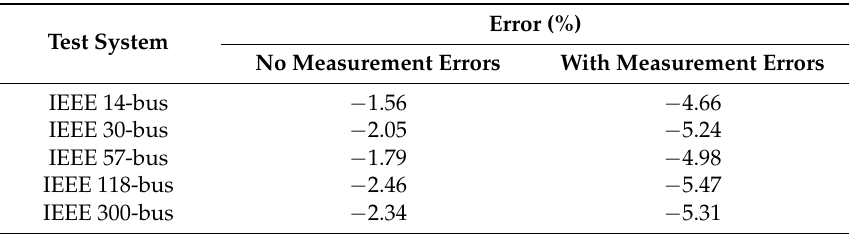
Table 6. Effects of measurement errors to VSB